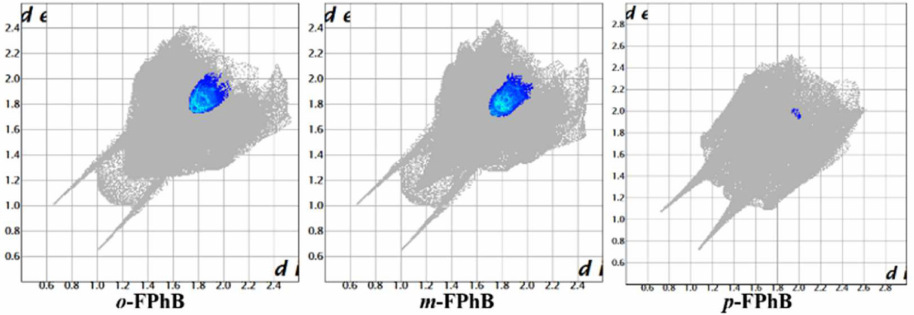
Figure 6. Fingerprints of the C ··· C interaction for o -FPhB , m -FPhB , and p -FPhB